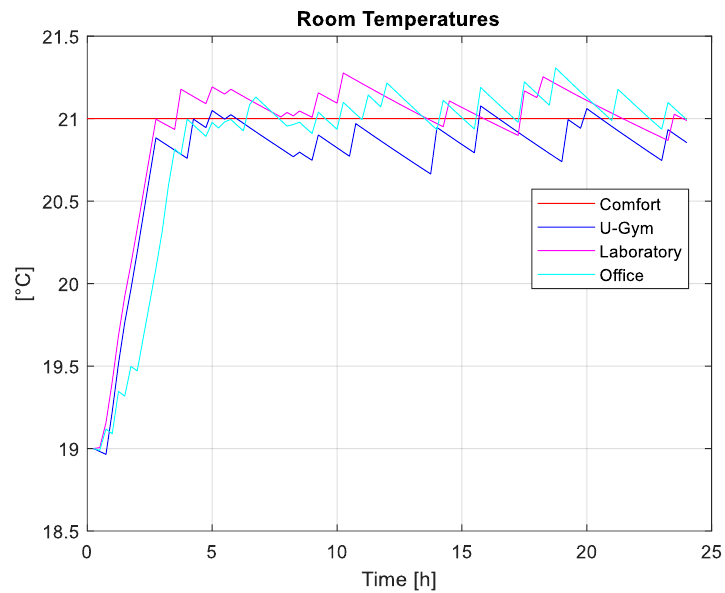
Figure 14. Room temperature profiles in the case of only comfort temperature tracking.